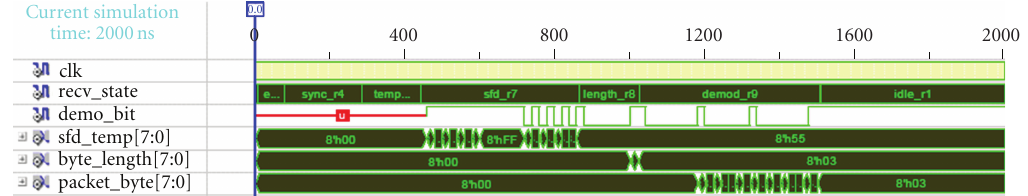
Figure 8: Timing sequence of signals in the receiver.